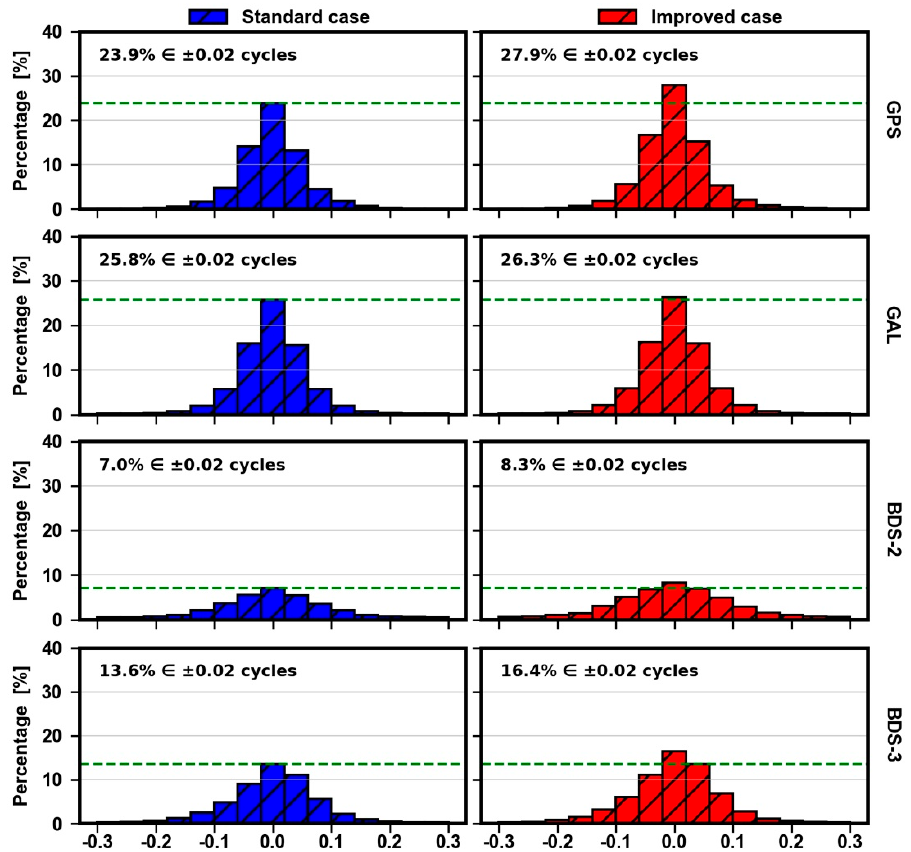
Figure 19. Residual distributions of NL ambiguities for the standard case and improved case for the Case 4 network.